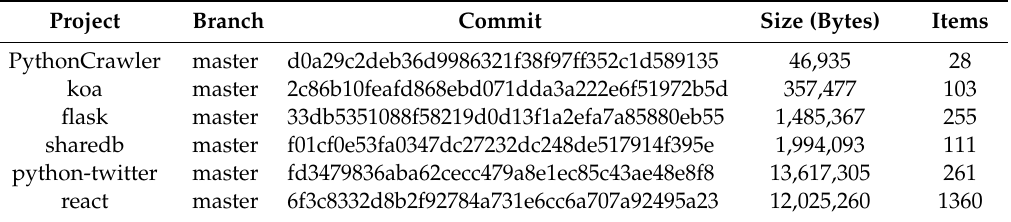
Table 2. Six open-source software projects selected for experimental